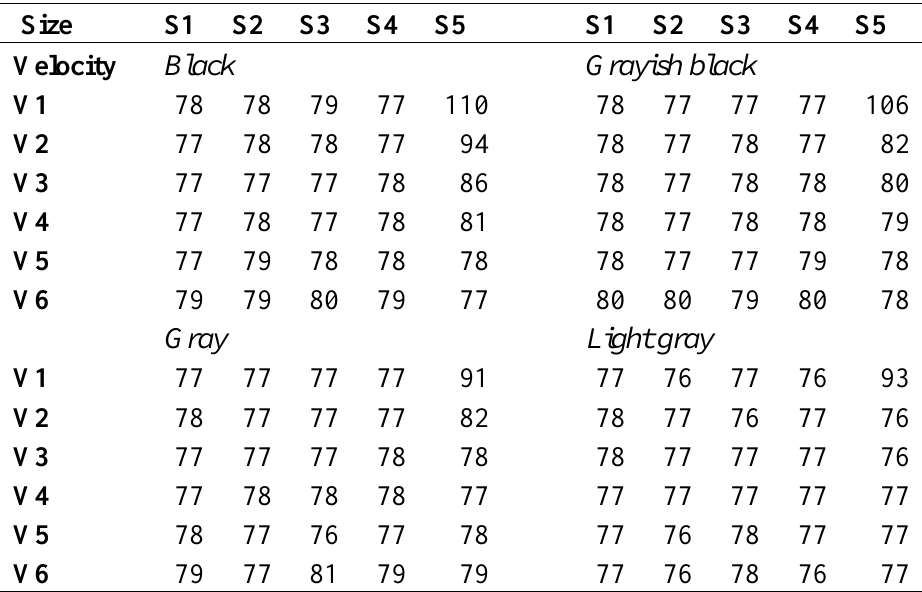
Table 1. The maximum contrast or intensity difference (gray scales 0–255) in the frame where the pendulum is at maximum speed for each size S (1.60, 0.95, 0.80, 0.65, 0.60 cm), velocity V (4.91, 6.02, 6.95, 7.77, 8.51, 9.19 km h –1 , respectively) and color (black, grayish black, gray, light